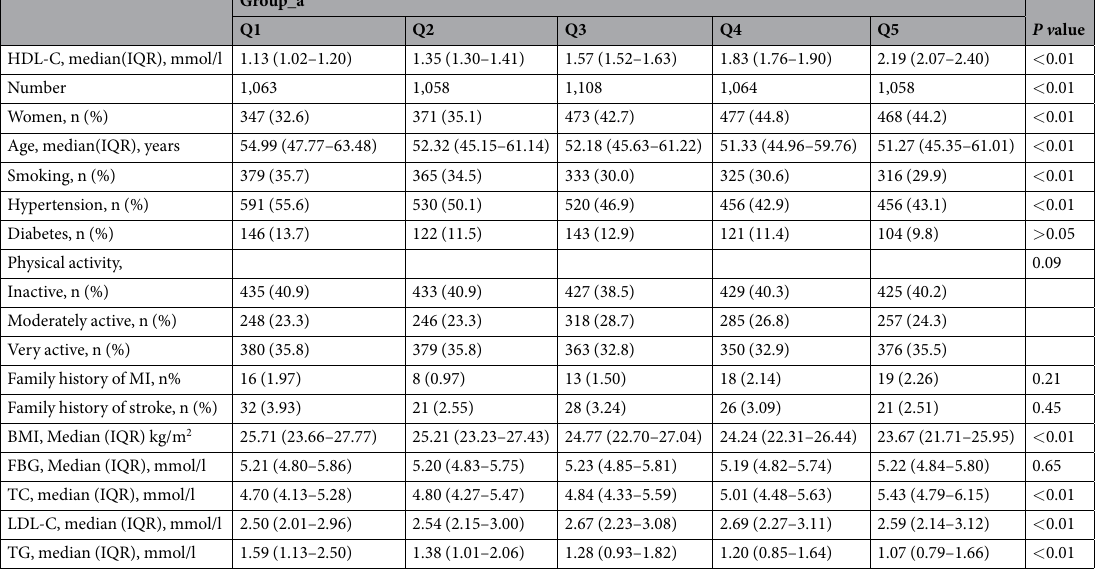
Table 1. Median baseline attributes of patients by HDL-C quintiles. IQR: interquartile